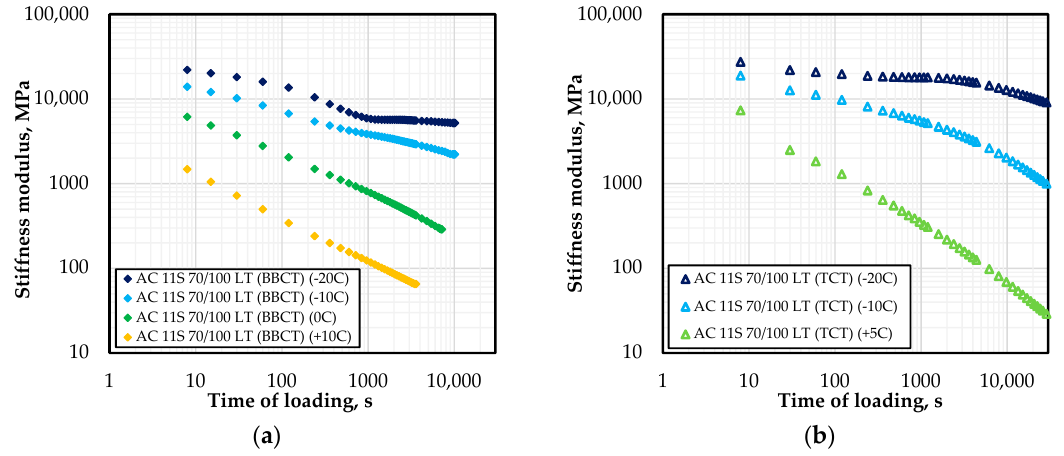
Figure 6. Creep test results—stiffness curves for AC 11S 70/100 LT ( a ) BBCT; ( b ) TCT.